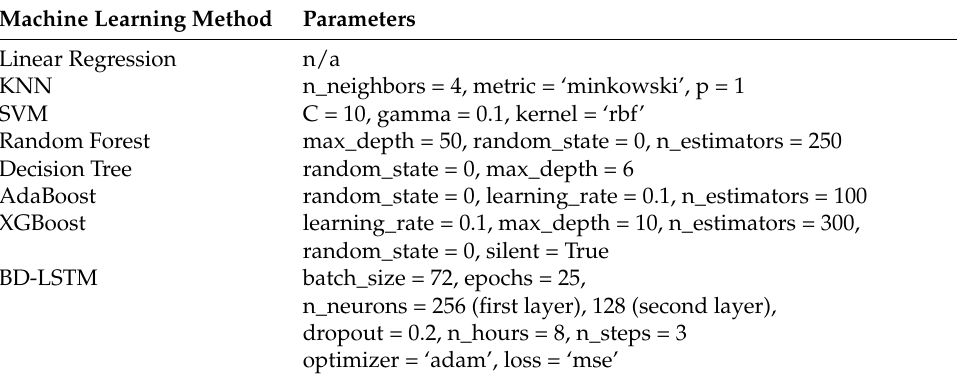
Table 2. Machine learning algorithm parameters used in Python scikit-learn and